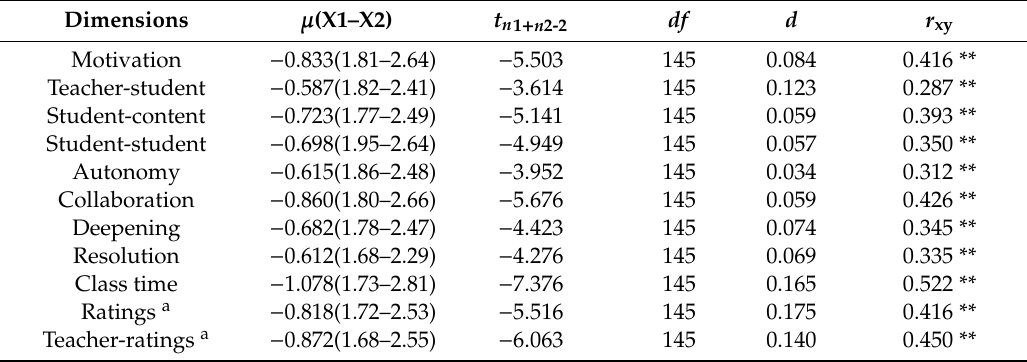
Table 3. Study of the value of independence between control group and experimental